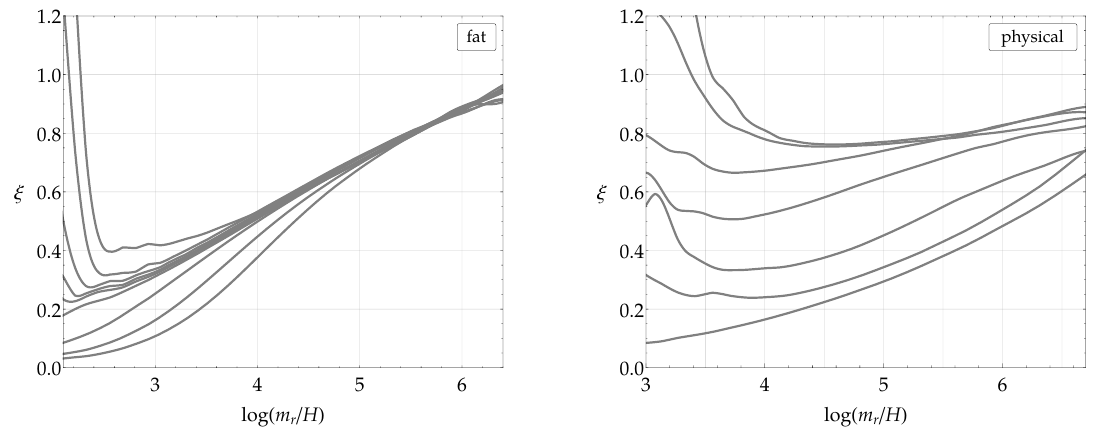
Figure 22 . Convergence of (cid:24) ( t ) to the attractor solution starting from random initial conditions with di(cid:11)erent values of k max =m r , between 1 = 2 and 1 = 50, for the fat string (left) and physical (right)